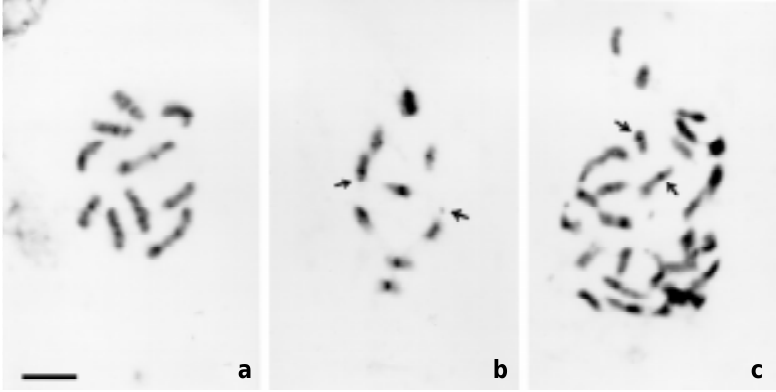
Figure 1 - Giemsa C-banding in mitotic chromosomes of Rhynchospora . a ) R. ciliata with 2n = 10. b ) R. barbata with 2n = 10. Arrows indicate terminal bands. c ) R. nervosa with 2n = 30. Arrows indicate terminal and interstitial bands. Bar represents 5 m